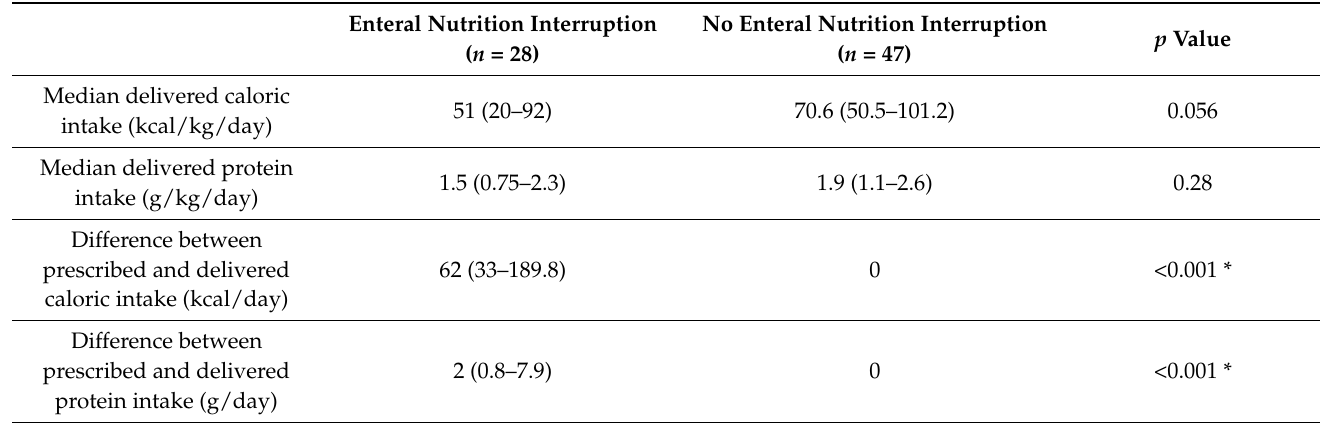
Table 2. Energy and protein delivery in children with any enteral nutrition interruption and without enteral nutrition